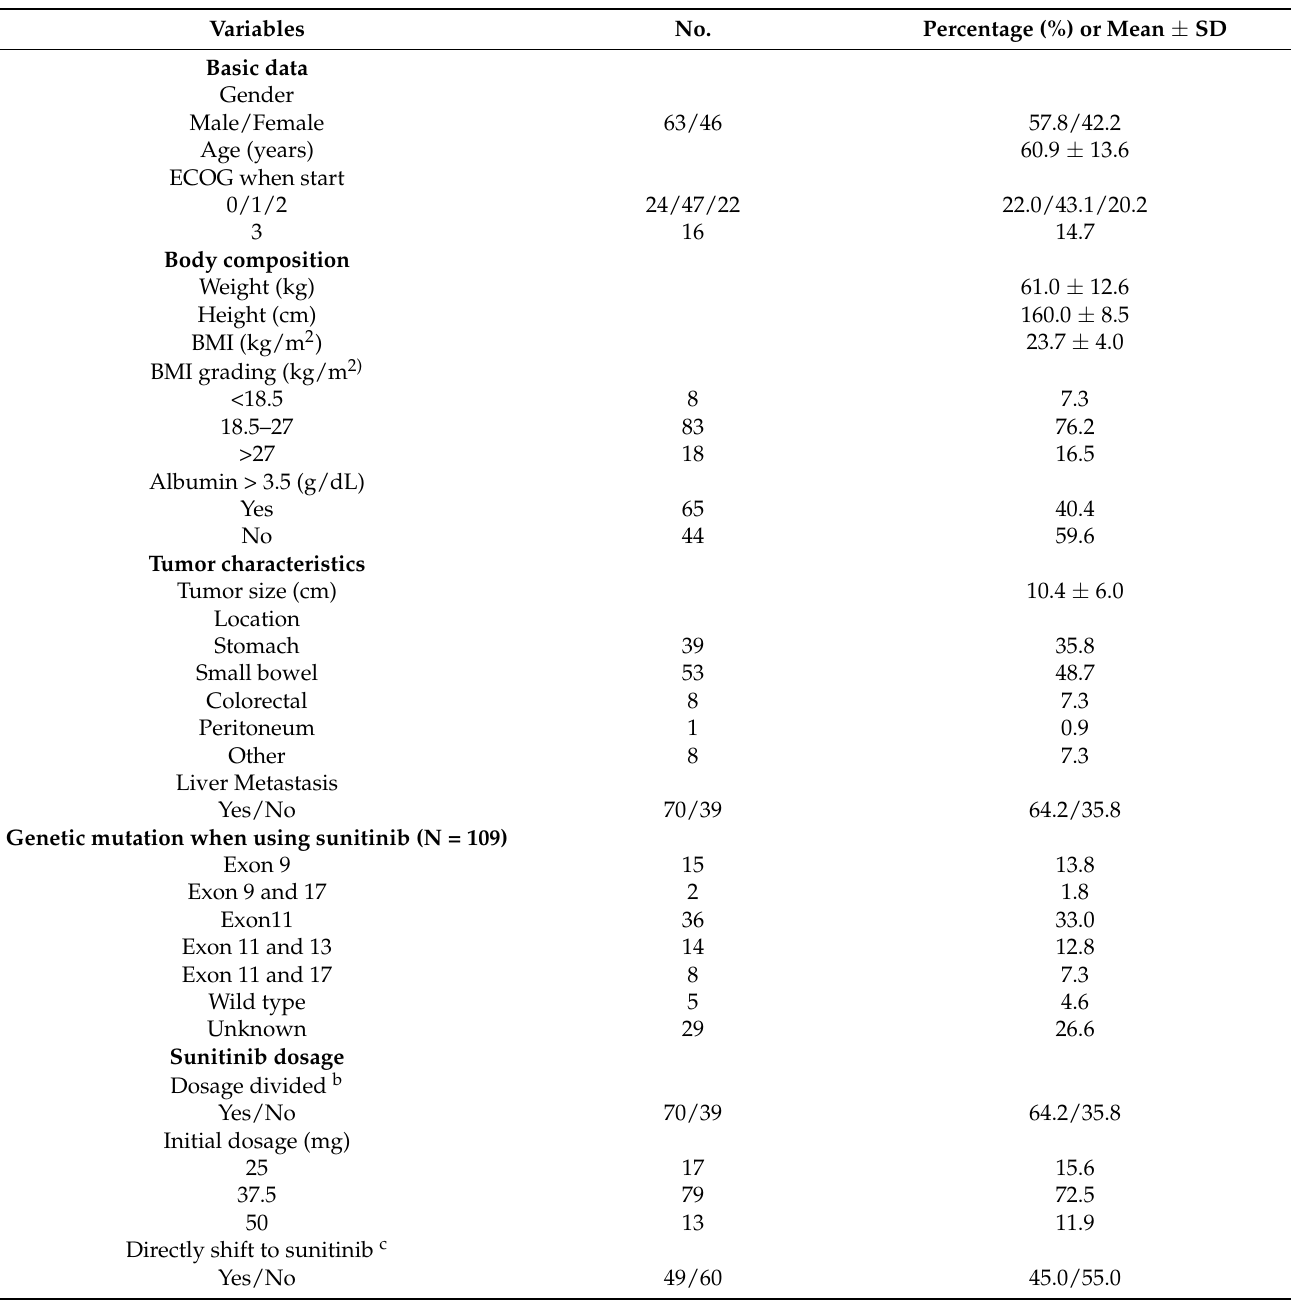
Table 1. The demographic characteristics of 109 advanced GIST patients under Sunitinib